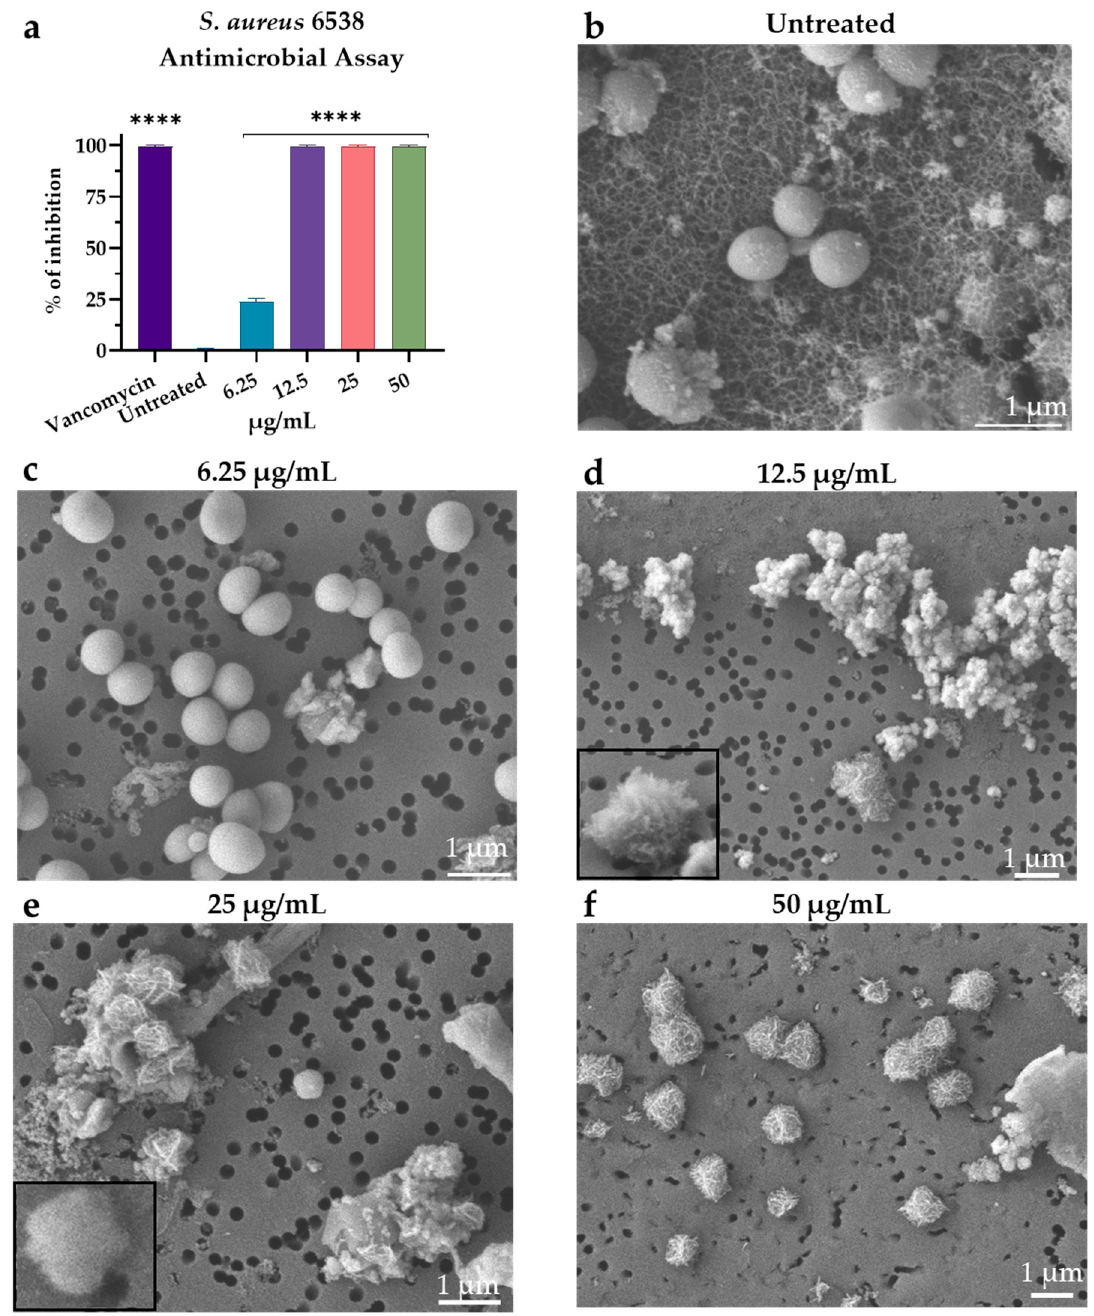
Figure 3. SEM visualization of S. aureus cells treated with M15RL in the microtiter assay conditions ( a ). In control ( b ) and in the sample treated with M15RL at concentration lower than MIC ( c ), S. aureus cells present a healthy morphology. Differently, when treated with MIC concentration ( d) and over ( e , f ), cells lose their integrity, and cytoplasmatic material is reversed outside the cells. Statistical analyses were determined by ANOVA with Dunnett’s test for multiple comparisons. Significances are referred to the untreated bacterium. **** p < 0.0001.